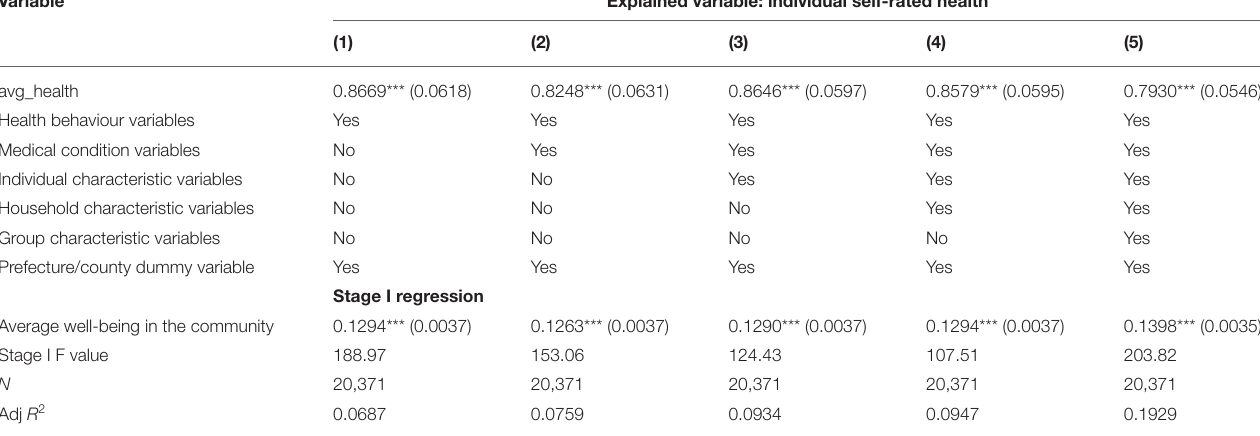
TABLE 3 | 2SLS regression results for instrumental variables. Variable